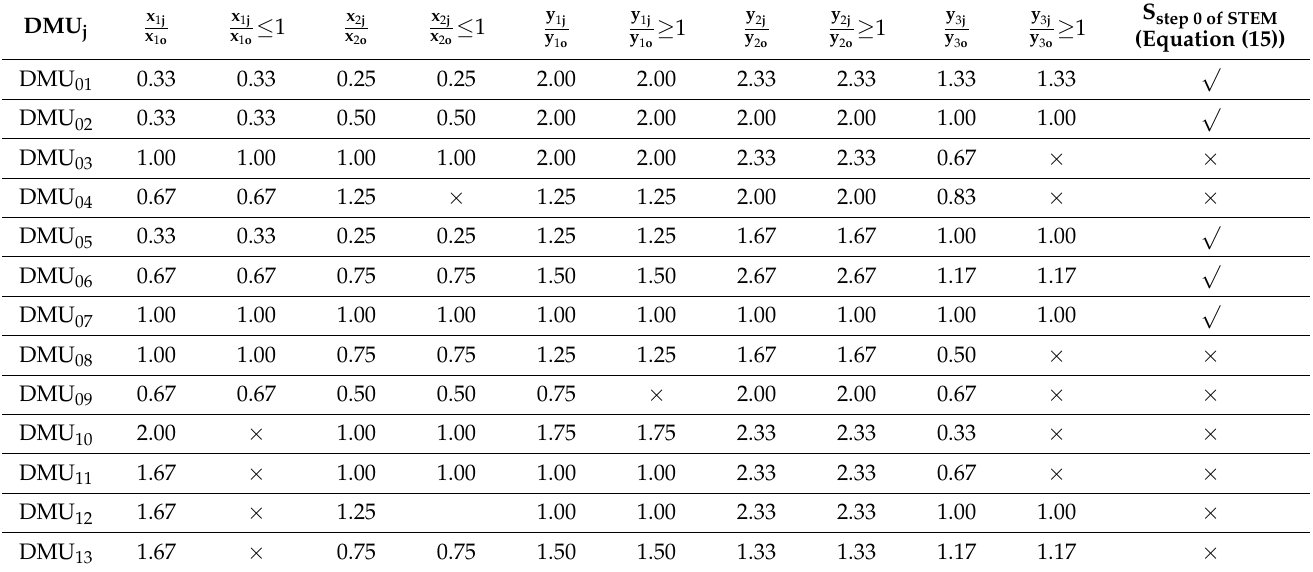
Table A8. Applying the first target finding stage for DMU 07 (the second case study). DMU